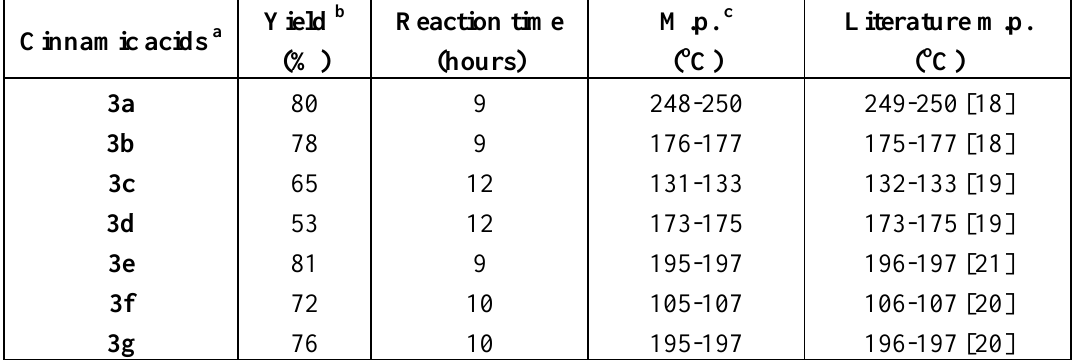
Table 2. Cinnamic acids prepared by direct synthesis with boron tribromide Cinnamic acids